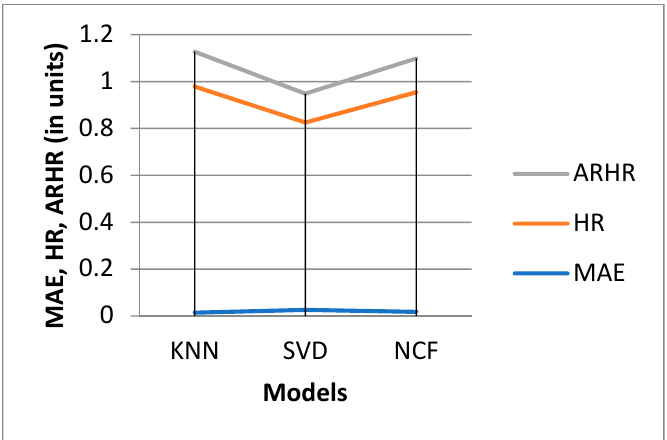
Figure 16. Comparative results of different models in terms of MAE, HR and ARHR in 80:20 training–testing scenario.